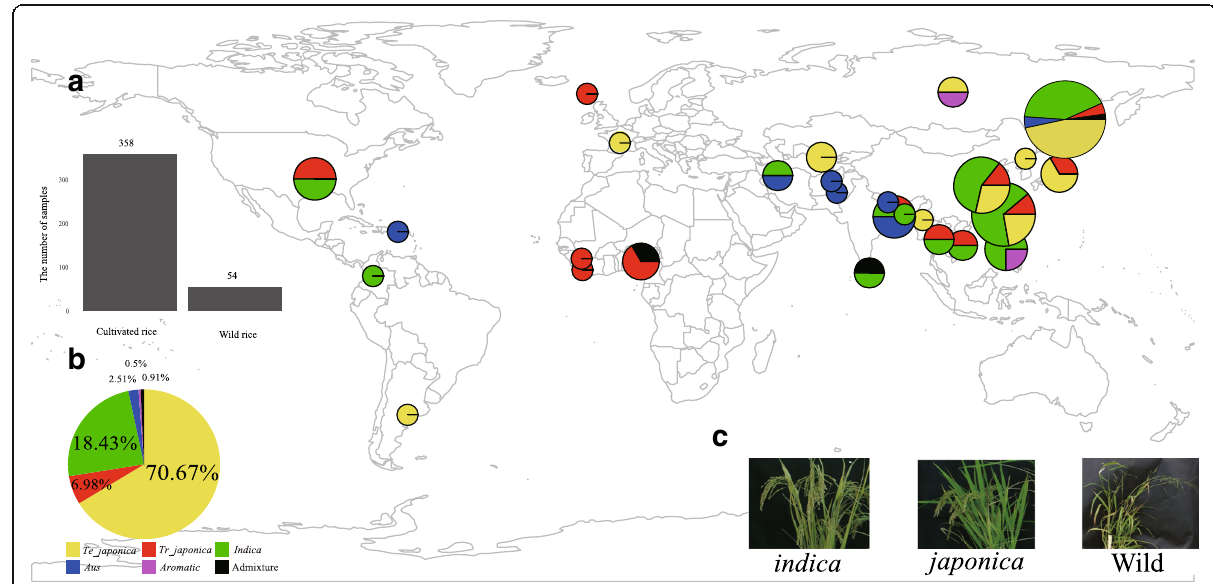
Fig. 1 Distribution of 412 rice varieties from the world. ( a ) The total 412 rice varieties are collected from the world, including 358 cultivated varieties and 54 wild varieties. ( b ) The large pie chart summarizes the distribution of subgroups in the 358 Asian rice, and the sample charts on the world map correspond to the country-specific distribution of subgroups (in case of space, some areas have more than one country, but are not display in an intact fashion in this world map). ( c ) The 3 graphs below present some typical phenotypes of indica, japonica and wild rice